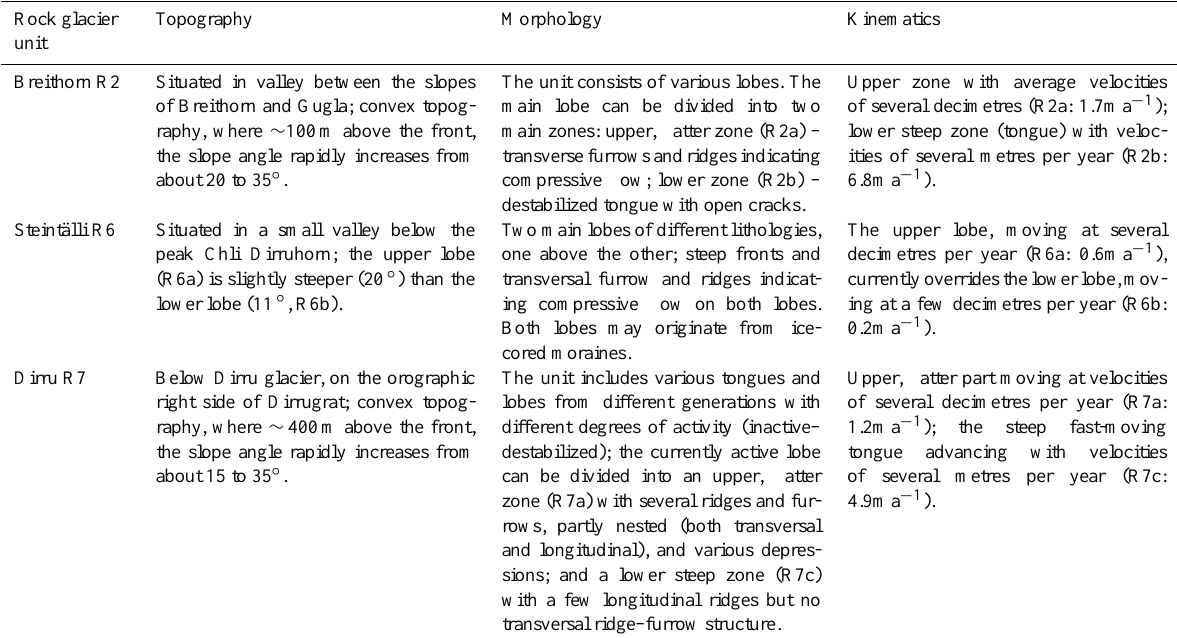
Table 2. Main characteristics regarding topography, morphology, and kinematics of the three investigated rock glaciers (Wirz et al., 2013; Delaloye et al., 2010, 2013; Wirz et al., 2015). Description of kinematics is based on expert knowledge (Dr. Hugo Raetzo, Federal Office for the Environment) and published observations (Delaloye et al., 2008b; Strozzi et al., 2009a, b; Delaloye et al., 2010, 2013; Wirz et al., 2015). In addition, for each GPS station the average velocities from summer 2011 to summer 2015 are given. Rock glacier Topography Morphology Kinematics unit Upper zone with average velocities The unit consists of various lobes. The Breithorn R2 Situated in valley between the slopes of several decimetres (R2a: 1.7ma − 1 ); main lobe can be divided into two of Breithorn and Gugla; convex topog- lower steep zone (tongue) with veloc- main zones: upper, flatter zone (R2a) – raphy, where ∼ 100m above the front, ities of several metres per year (R2b: transverse furrows and ridges indicating the slope angle rapidly increases from 6.8ma − 1 ). compressive flow; lower zone (R2b) – about 20 to 35 ◦ . destabilized tongue with open cracks. Steintälli R6 transversal furrow and ridges indicat- ing compressive flow on both